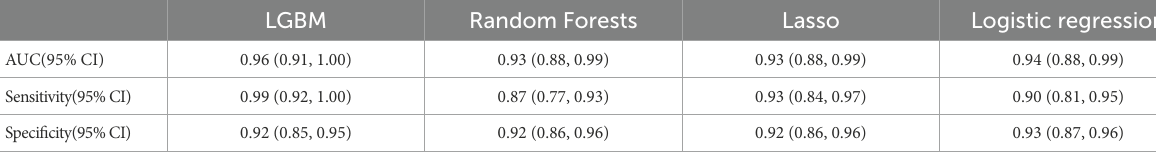
TABLE 2 Summary of area under the curve, sensitivity, specificity data for the two machine learning, and two statistical models used for the study.